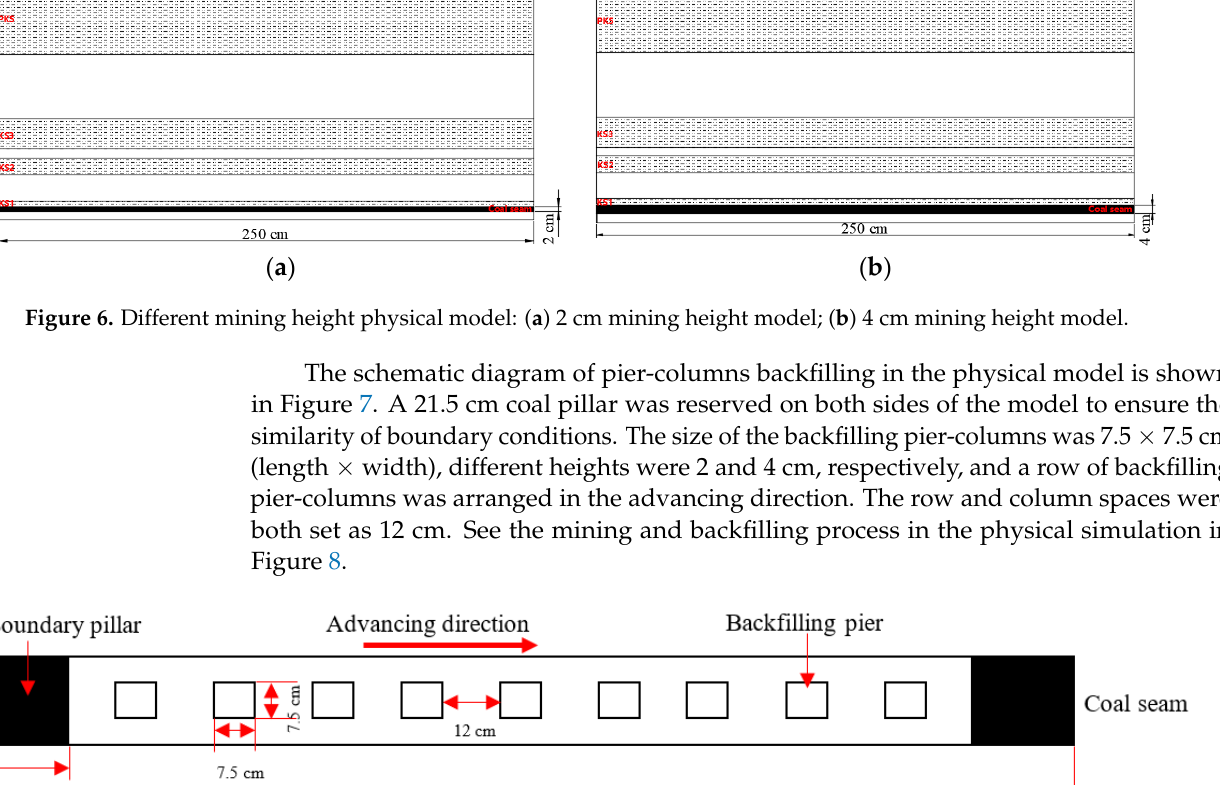
Figure 7. Schematic diagram of backfilling in the physical model.